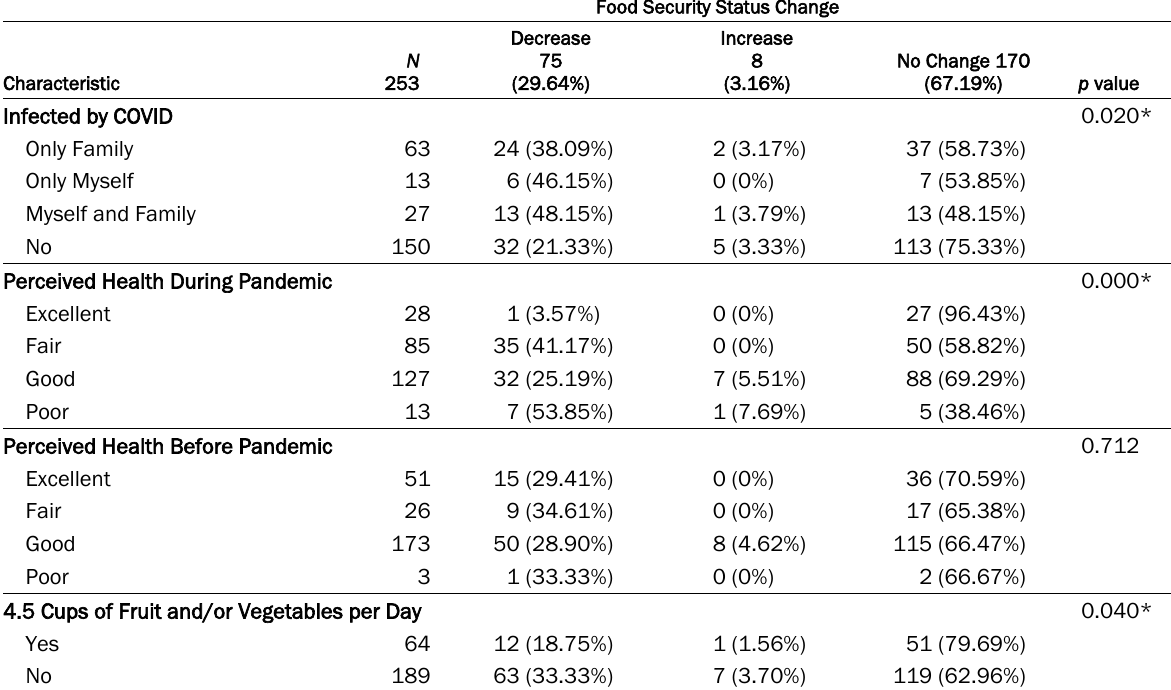
Table 3. Results of Fisher Exact Test for Food Security Status Change and Health